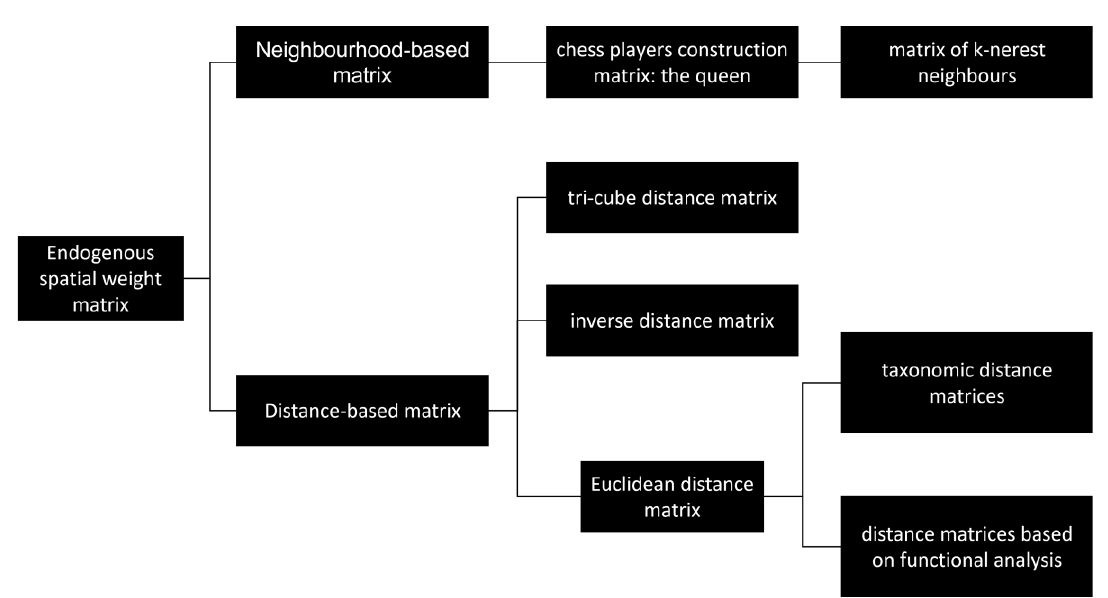
Figure 5. Classification of types of spatial weight matrices according to the way they are constructed.